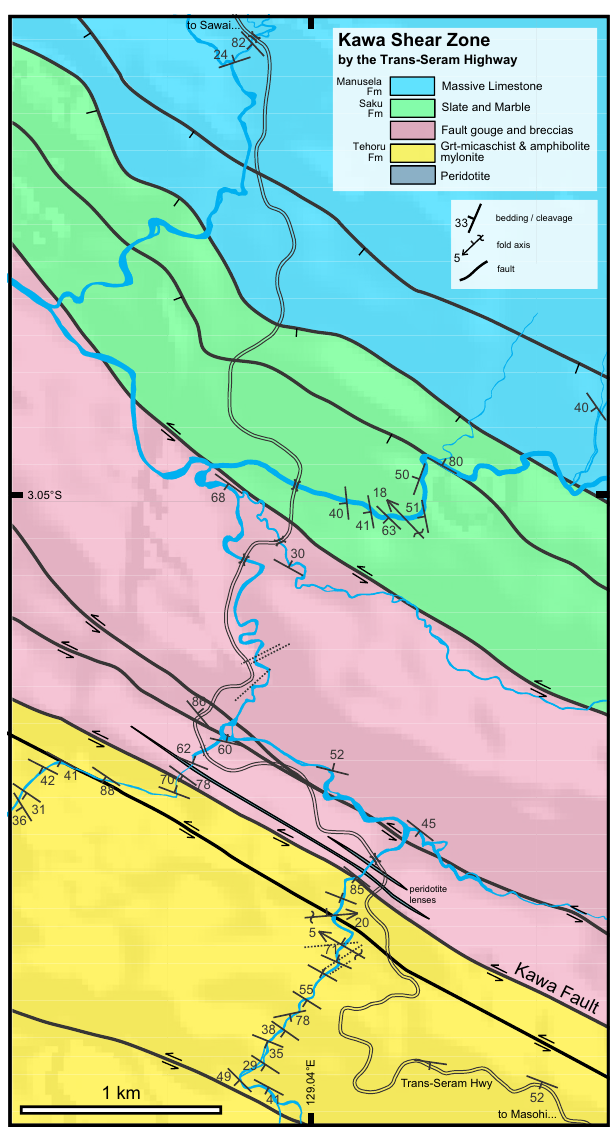
Fig. 11. Geological map of the Kawa Fault Zone in the vicinity of the Trans-Seram Highway. See Fig. 12 for cross section drawn perpendicular to the strike of the faults. See Fig. 3 for location of this map in central Seram. Note the thin slivers of peridotite im- mediately north of the Kawa Fault. The short dotted lines represent minor normal faults exposed in the